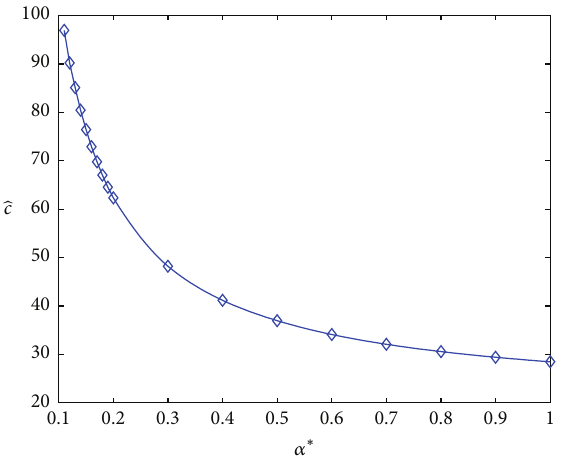
Figure 3: The curve of ̂𝑐 along with 𝛼 ∗ .